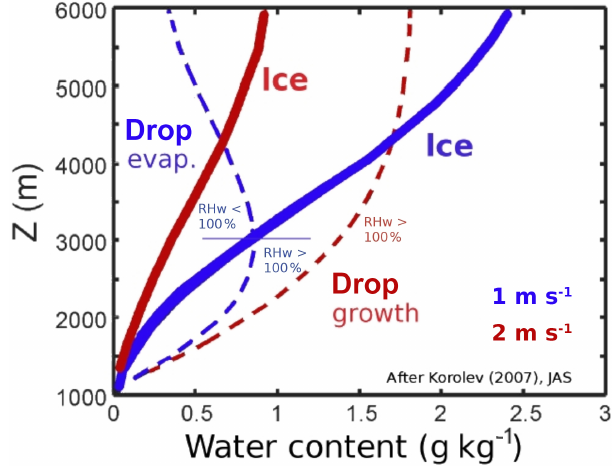
Figure 2. Liquid water content (dashed lines) and ice water con- tent (solid lines) development with altitude Z ( ∼ 1/temperature) in mixed-phase clouds for different vertical velocities (adapted from Korolev, 2007, with modification). Blue lines (updraught 1ms − 1 ): the cloud glaciates when RH w falls below 100% (Wegener– Bergeron–Findeisen regime); red lines (updraught 2ms − 1 ): RH w stays above 100%, liquid droplets and ice crystals coexist (coexis- tence